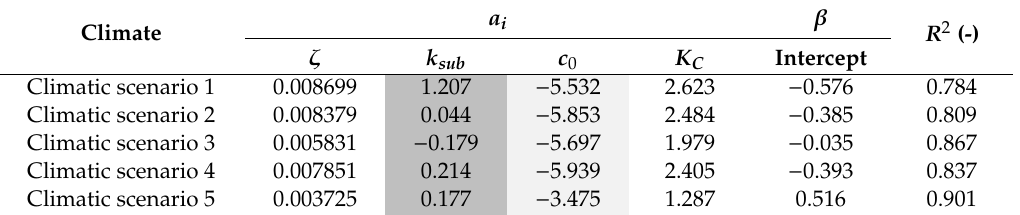
Table 3. Results of the linear regression between morphological and vegetation parameters and Fu’s parameter for all the considered climates. The a i , β , and R 2 respectively represent the coe ffi cients related to each morphological and vegetation parameter, the constant term, and the coe ffi cient of determination of the linear equations that allow obtaining an empirical estimate of ω . All terms of the equation are obtained by stepwise regression, linking the random generated morphological and vegetation parameters’ sets (which value’s range are reported in Table 2) and the associated ω . The colors of the cells are related to the p -value: white cells represent the p -value equal to 0, light grey cells represent p -values higher than 0 and lower than 0.25, and the dark grey cells indicate p -values bigger than 0.25. a i β Climate R 2 (-) ζ k sub c 0 K C Intercept Climatic scenario 1 0.008699 1.207 − 5.532 − 0.576